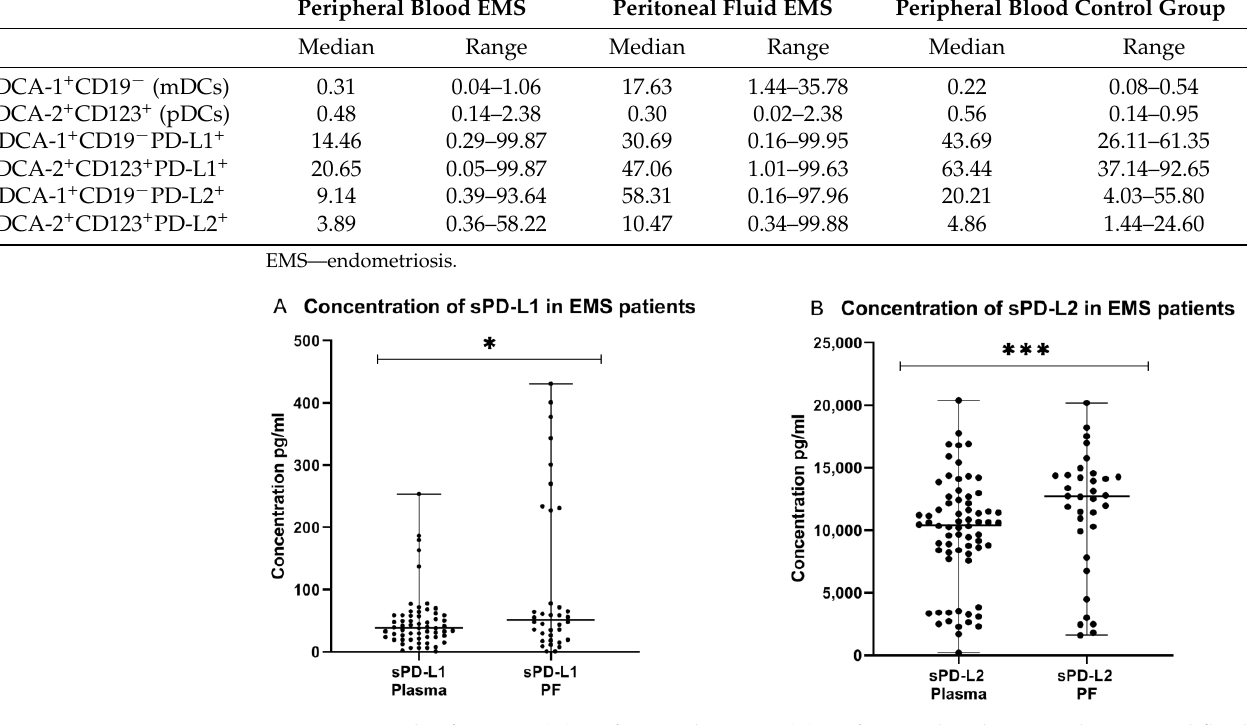
Figure 7. Levels of sPD-L1 ( A ) pg/mL and sPD-L2 ( B ) pg/mL in the plasma and peritoneal fluid of patients with endometriosis. The median values with the following signs indicate statistically significant differences: * p < 0.05, *** p < 0.001.